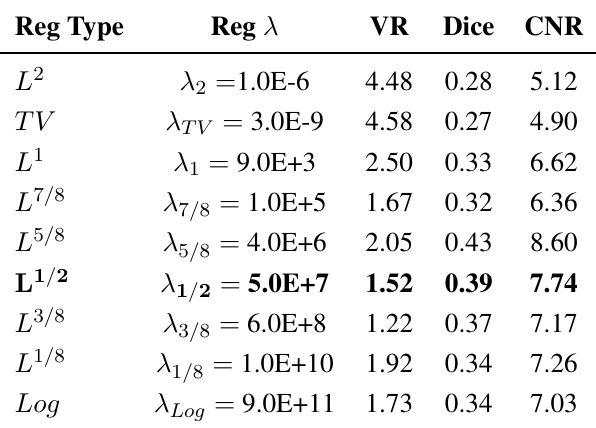
Table 5. Metrics for image quality for the cubic phantom, with the best regularization method highlighted in